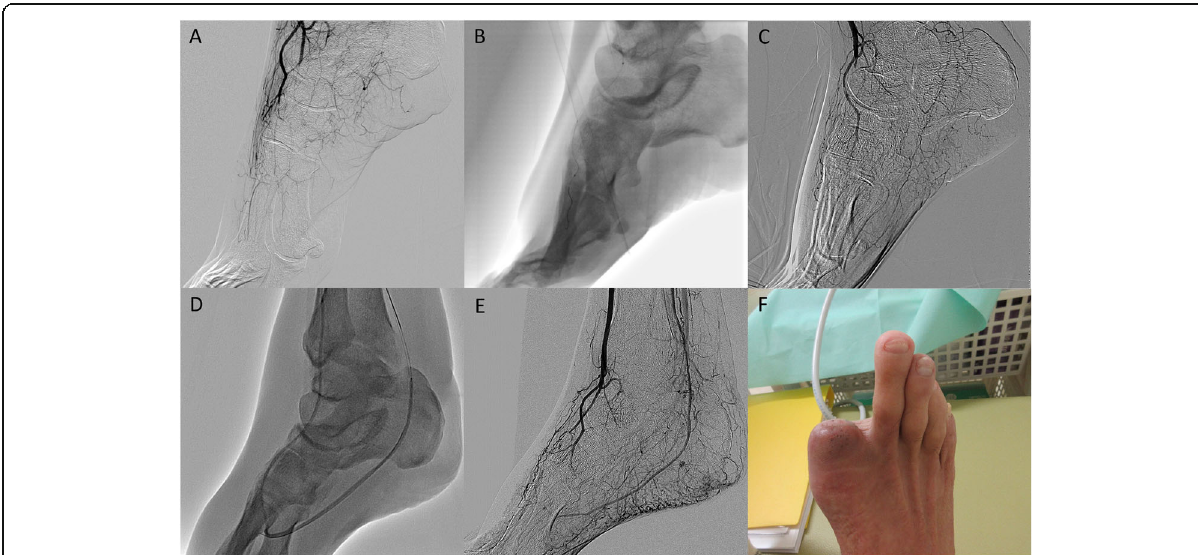
Fig. 4 Additional pedal artery angioplasty in case 2. a Baseline angiography showing total occlusion in the pedal artery lesion in another hospital. b Balloon dilated in the dorsalis pedis artery (DPA) and digital artery forward first toe. c Final angiography showed insufficient revascularization in another hospital. d Pedal artery angioplasty was performed in our hospital. e Antegrade blood flow from the bilateral tibial arteries forward his foot was obtained. f His wound completely